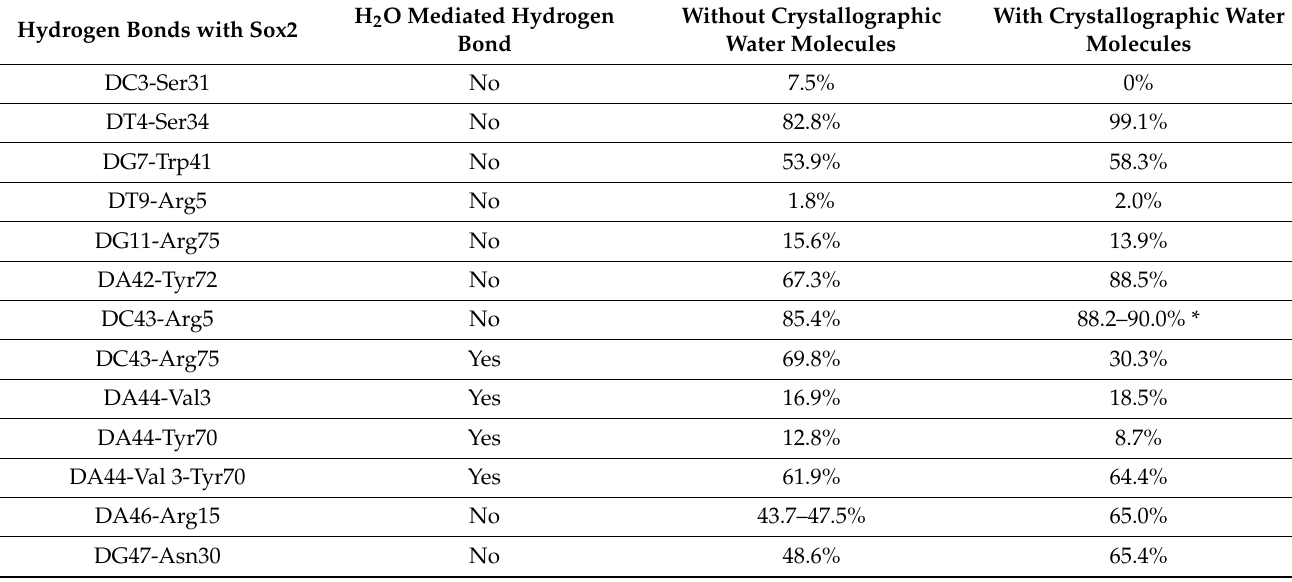
Table 2. Prevalence (% time) of hydrogen bonds and water-mediated interactions observed in the 1GT0 crystal structure during the MD simulations.